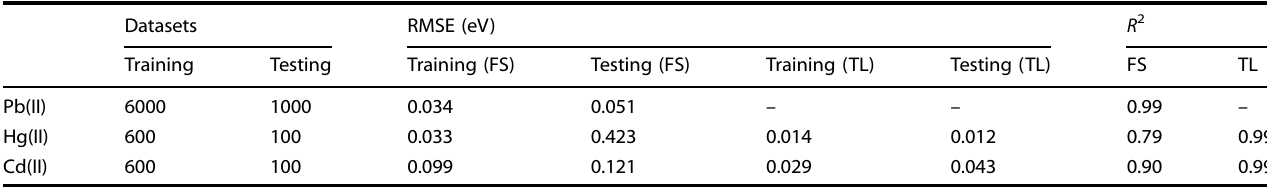
The Pb(II)/g-C 3 N 4 structure was predicted with 7000 DFT adsorption energies, while the Hg(II)/g-C 3 N 4 and Cd(II)/g-C 3 N 4 were predicted with 700 energies,